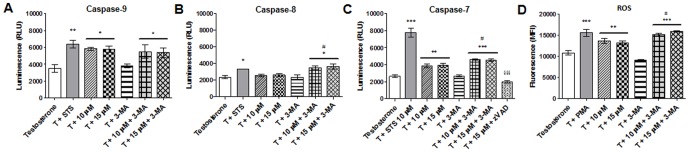
Activation of caspases and ROS production.Caspase-9 (A), caspase-8 (B) and caspase-7 (C) activities of MCF-7aro cells treated with exemestane after 3 days. The effects of 3-MA on caspase activities were also studied. Cells cultured with T were considered as control, cells treated with STS were considered as positive control and with Z-VAD-FMK was negative control. The results are presented as relative luminescence units (RLU). (D) ROS in MCF-7aro cells treated with exemestane after 3 days. It was also studied the effects of 3-MA. Cells cultured with T were considered as control and cells treated with PMA were as positive control for ROS production. The results are presented as mean fluorescence intensity (MFI). Results are the mean ± SEM of three independent experiments performed in triplicate. Significant differences between the control T versus treated cells, or between the control plus 3-MA versus cells with exemestane plus 3-MA are indicated by * (p<0.05), ** (p<0.01) and *** (p<0.001); between the cells treated with exemestane versus cells with exemestane plus 3-MA are indicated by # (p<0.05); between the cells treated with exemestane versus cells with exemestane plus Z-VAD-FMK are indicated by §§§ (p<0.001).